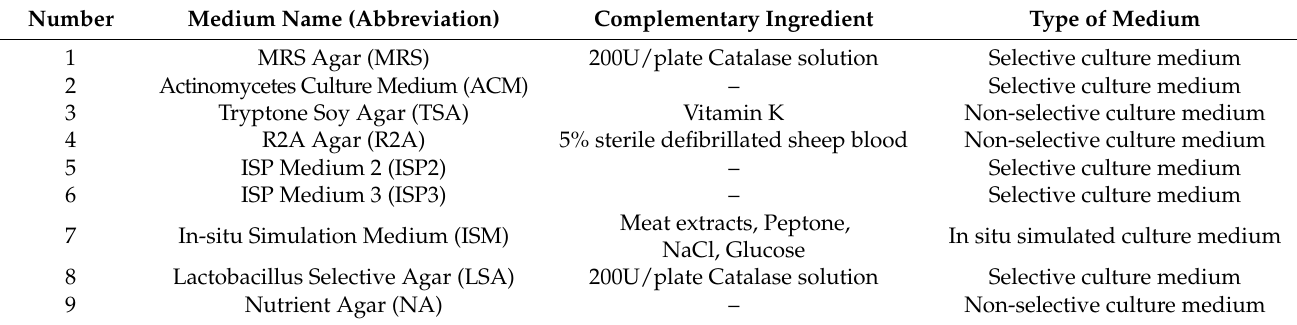
Table 1. Solid plate medium for bacterial culturomics in fermented